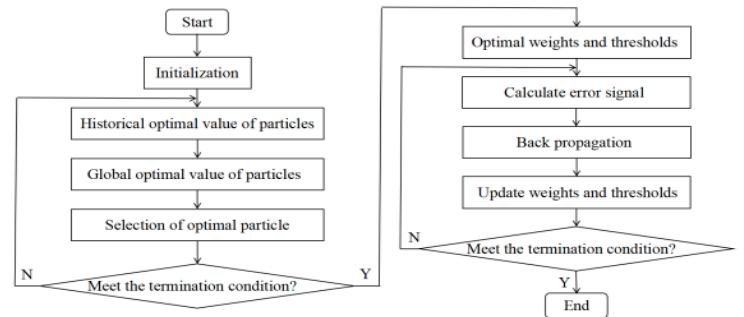
Figure 2. Temperature compensation flow using the QPSO algorithm.